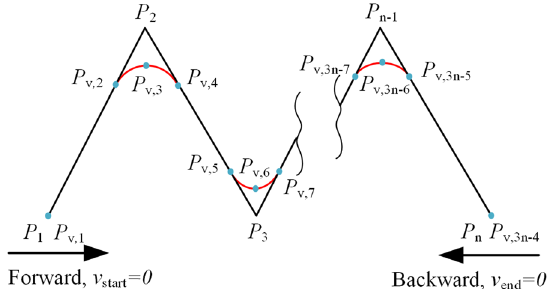
Figure 2 Schematic diagram of look-ahead